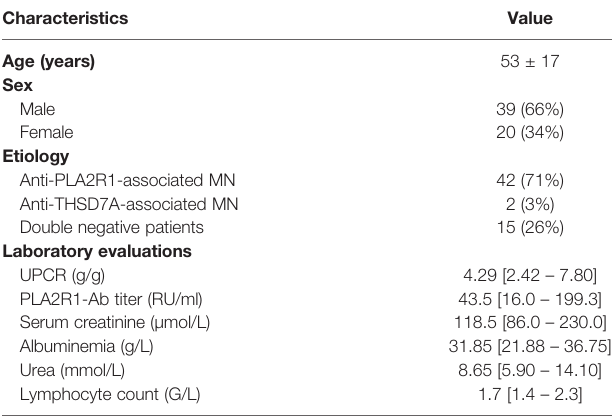
TABLE 1 | Baseline characteristics of MN patients ( n =59). Characteristics